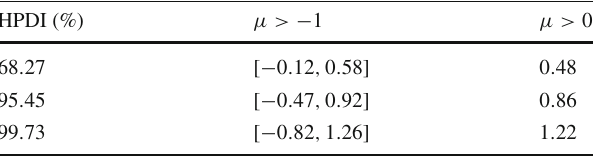
Table 1 HPDIs obtained using all 10 7 samples from the training set of S 1 . The result is shown both for μ > − 1 and μ > 0 (only the